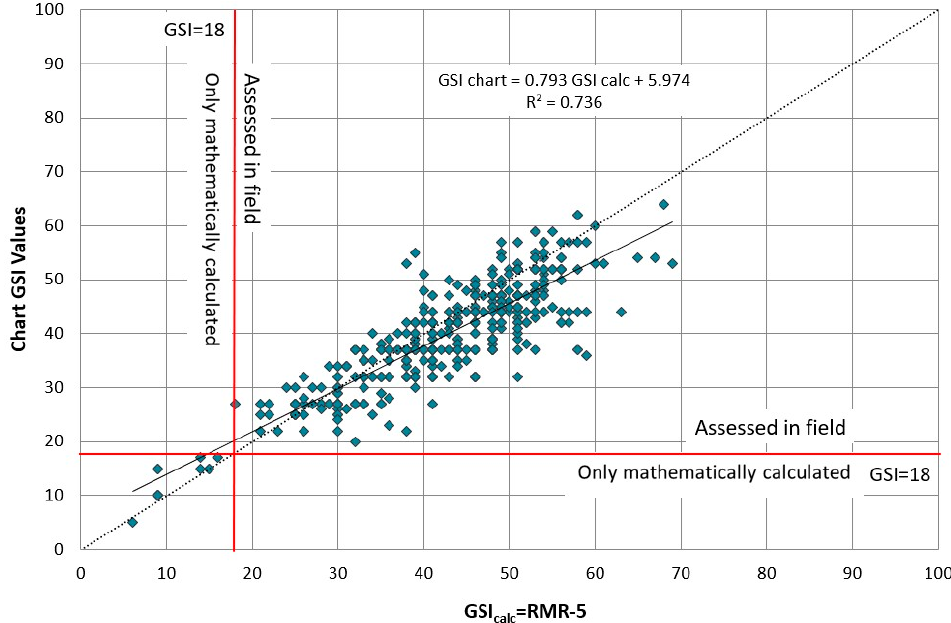
Figure 5. Correlations between Chart and calculated GSI values using Equation (1).